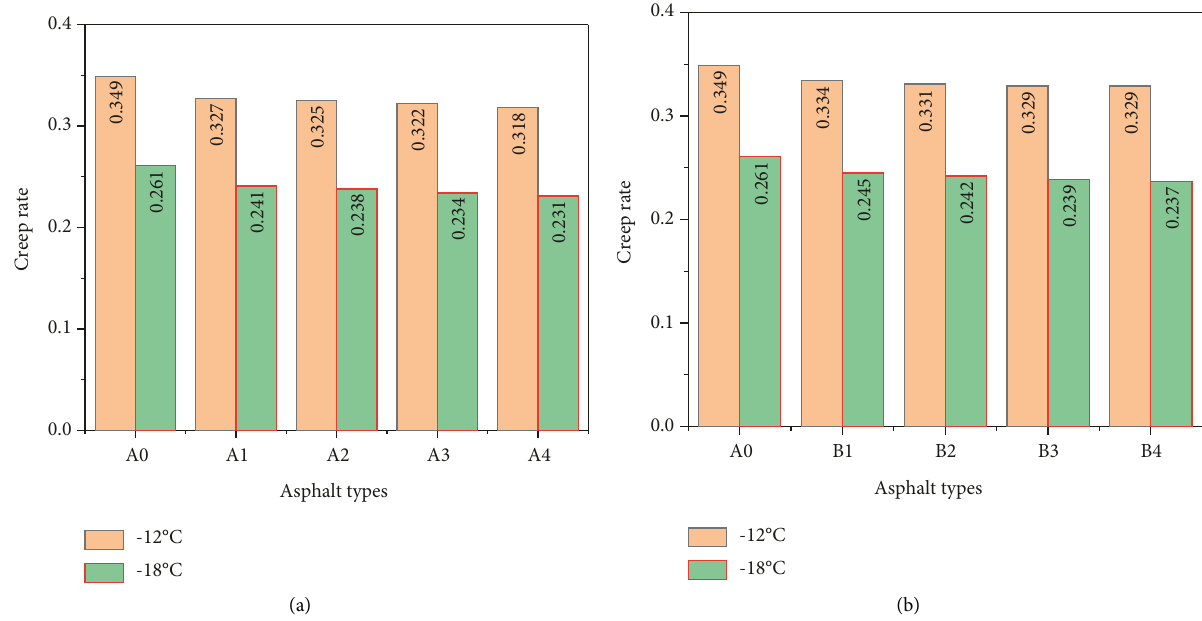
Figure 11: Creep rate of GOMBA at different dosage levels. (a) Effects of different GO dosages on the creep rate of bio-asphalt A and (b) effects of different GO dosages on the creep rate of bio-asphalt